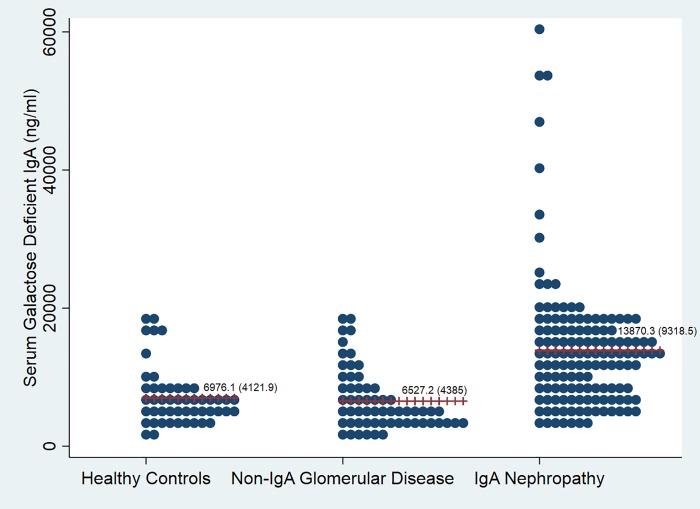
Dotplot showing individual serum galactose deficient IgA1 values in all three groups.